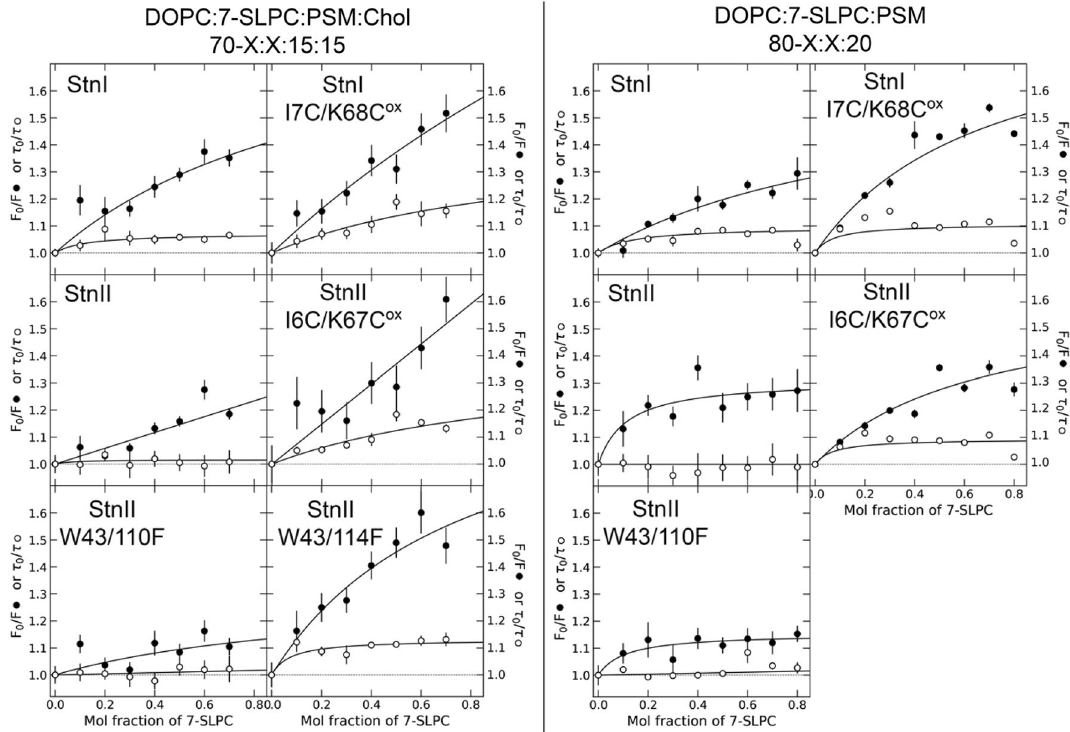
Figure 3. Fluorescence quenching in membranes. Quenching of fluorescence emission of Stn variants by increasing amounts of 7-SLPC in membranes composed of DOPC:7-SLPC:PSM:Chol (left side panels) or DOPC:7-SLPC:PSM (right side panels) in molar relations of 70-X:X:15:15, or 80-X:X:20, respectively, where X is the molar fraction of 7-SLPC. Since StnII-W43/114F cannot bind the Chol-lacking membranes used, the analysis could not be done with this membrane composition. Closed symbols: F 0 /F (steady state). Open symbols: τ 0 /τ (lifetime data). Data are average ± SEM of n = 2–3. Lines are guides to the eye. In all cases, RMSD was < 0.04, and χ 2 red <